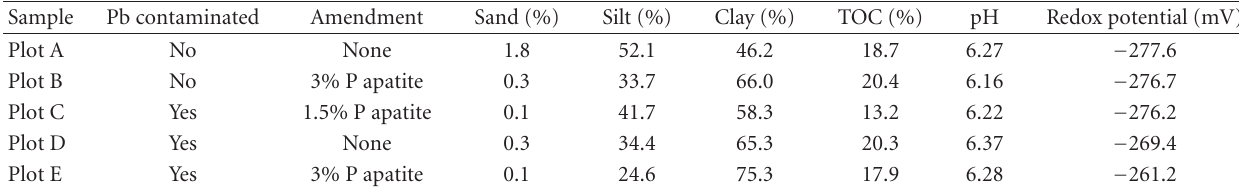
Table 1: Chopawamsic Creek sediment experimental plot contamination identification and amendment rate along with texture and organic carbon characteristics.